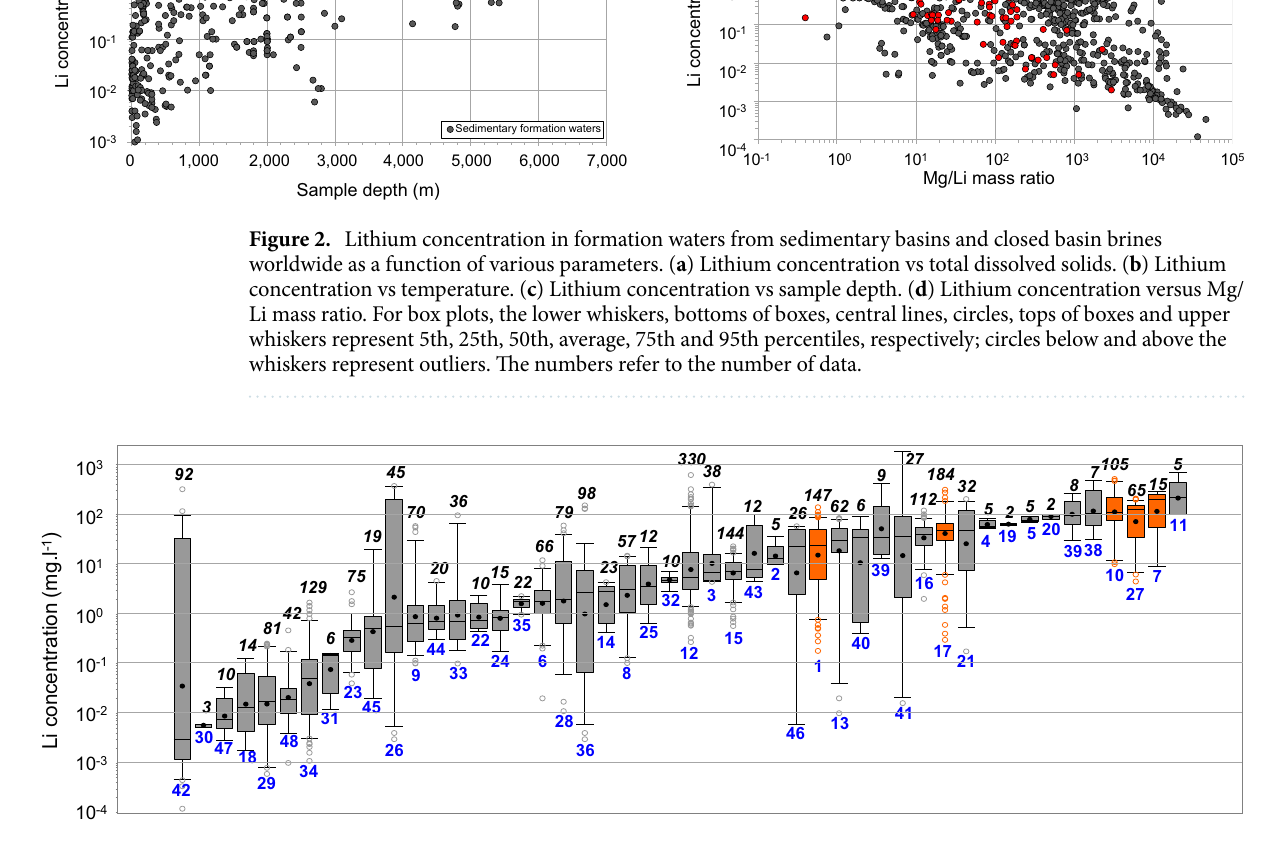
Figure 3. Lithium concentration in formation waters from sedimentary basins worldwide. Each boxplot represents one basin. The box plots are sorted by the increasing median value of Li concentration. The numbers in blue refer to the identification number of the basins (Fig. 1, Table 1). The numbers in black and italics refer to the number of data. Orange box plots indicate the sedimentary basins hosting the reservoirs considered for the resource estimation (see Fig. 5, Table 2). Lower whiskers, bottoms of boxes, central lines, circles, tops of boxes and upper whiskers represent 5th, 25th, 50th, average, 75th and 95th percentiles, respectively; circles below and above the whiskers represent